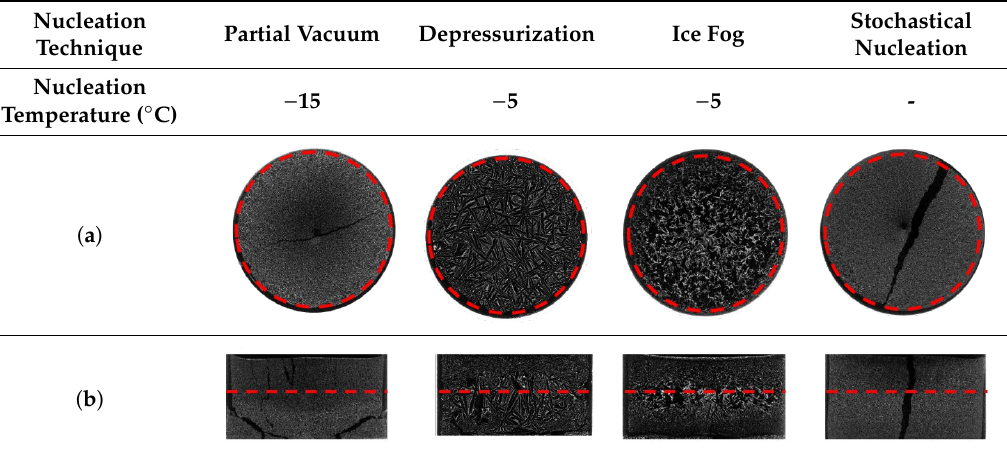
Table 4. Detailed characterization of cake structure by µCT for mAb1 at 100 mg/mL lyophilized in 20 cc vials. The nucleation temperatures are indicated per method. ( a ) Horizontal cross section from the middle of the cake. ( b ) Vertical cross section of the complete cake. Red lines indicate the position of the horizontal cross section from the entire cake.